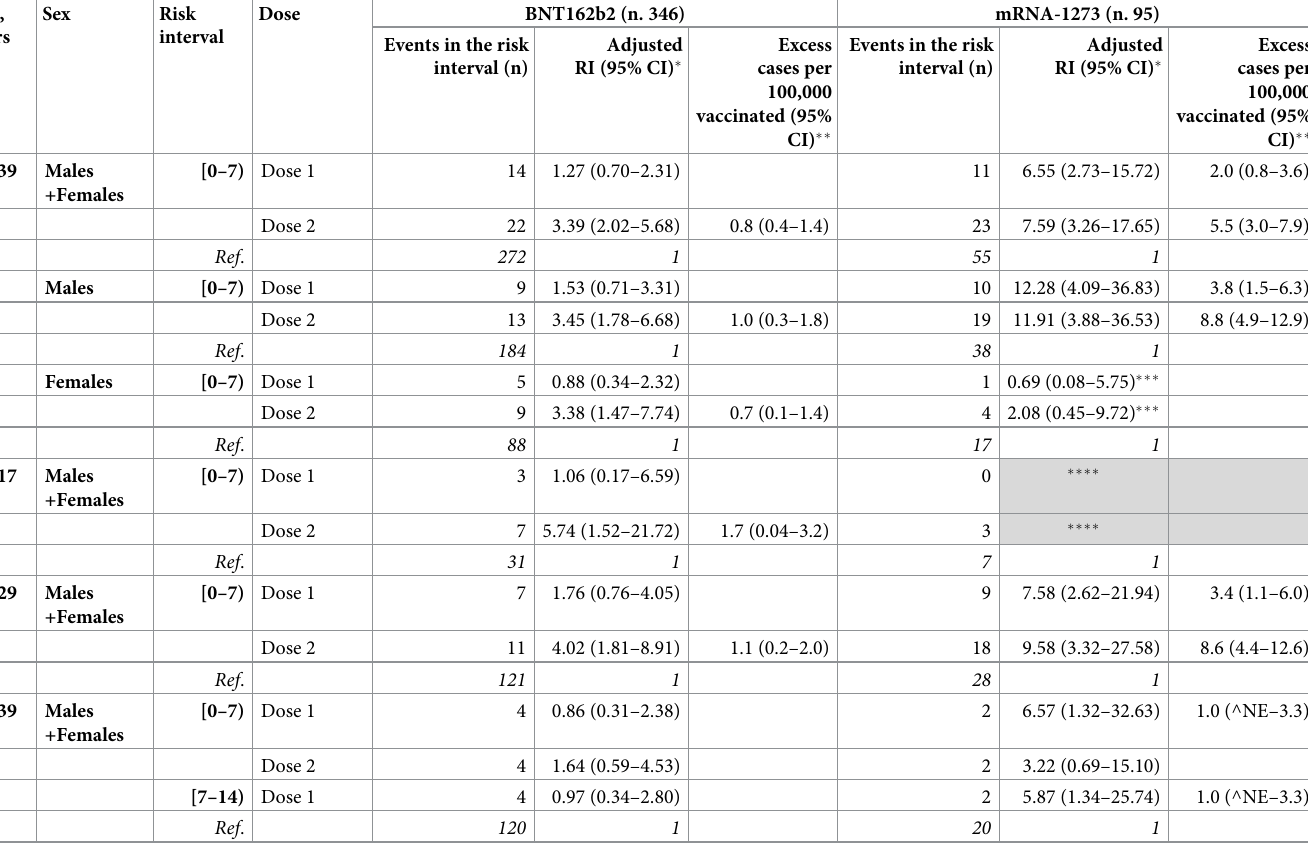
Table 3. Adjusted RI and excess of cases per 100,000 vaccinated in the 7-day risk periods after mRNA vaccination in the vaccinated population aged 12–39 years from 27 December 2020 to 30 September 2021 by sex, age group, and vaccine